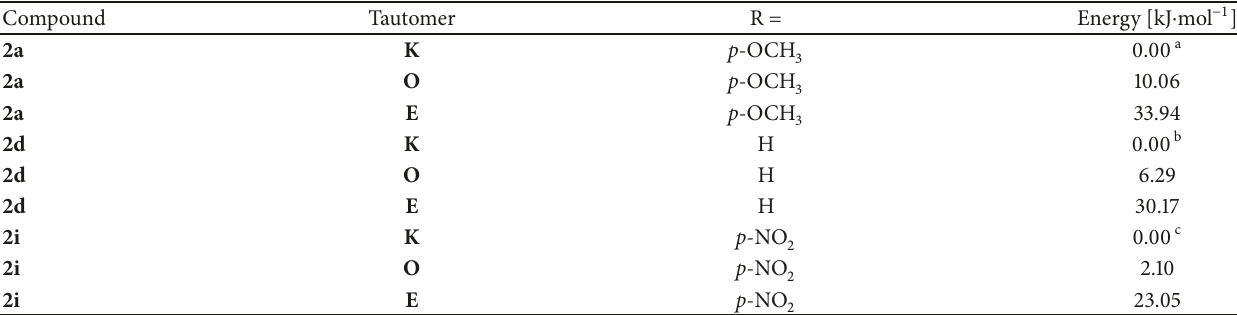
Table 4: MP2(6-311+G(d,p)) calculated relative energies [kJ ⋅ mol −1 ] of different tautomers.